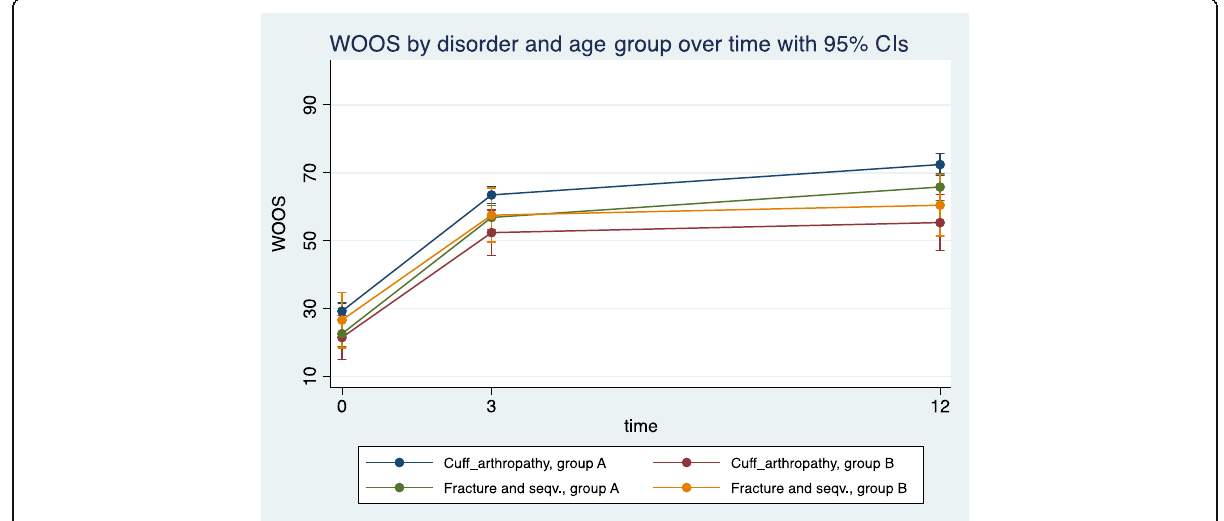
Fig. 3 Estimated multivariate marginal change over time in WOOS with 95% CI was statistically significant in both groups. Comparing the WOOS over